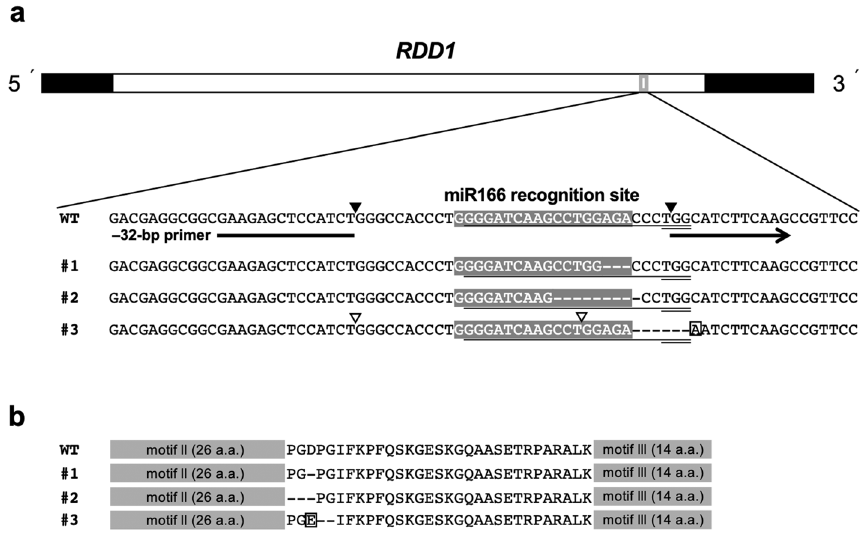
Figure 1. In-frame mutations around the RDD1 miR166 recognition site. ( a ) Nucleotide sequences of RDD1 in the wild-type (WT) and three independent lines of R1 -Cas plants (#1–3). The untranslated and coding regions are indicated by black and white bars, respectively. The nucleotide sequences of the miR166 recognition site are boxed in gray, and the 20-nt target sequence and protospacer adjacent motif (PAM) are indicated by single and double underlines, respectively. Black and white arrowheads show the boundary sites of the 32-bp and 23-bp regions, respectively. The primer used to detect the absence of the 32-bp region (− 32-bp primer) is indicated by an interrupted arrow. A substituted nucleotide residue (adenine) in the R1 -Cas #3 plants is shown framed by a square. ( b ) The amino acid sequences of RDD1 in the WT and R1 -Cas #1–3 plants. Two highly conserved motifs (motifs II and III) are boxed in gray, and a substituted amino acid (glutamic acid) in the R1 -Cas #3 plants is framed by a